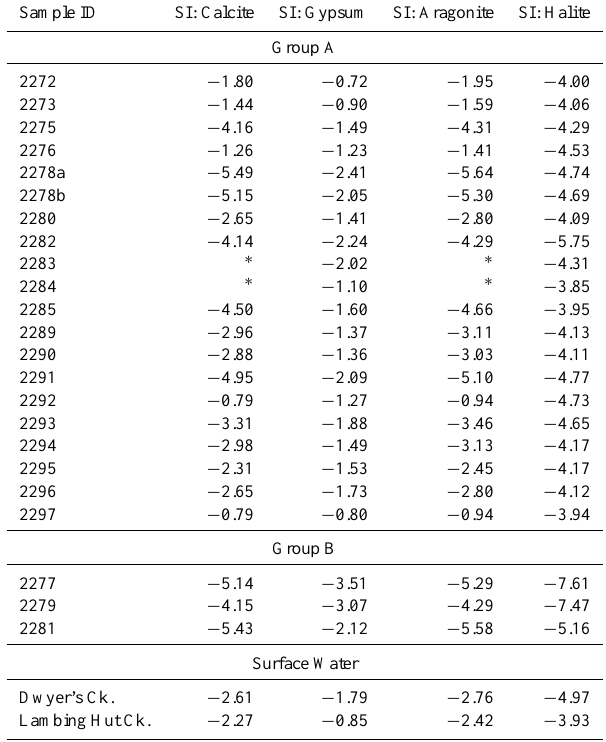
Table 8. Saturation indices for all the groundwater and surface wa- ter samples used in this